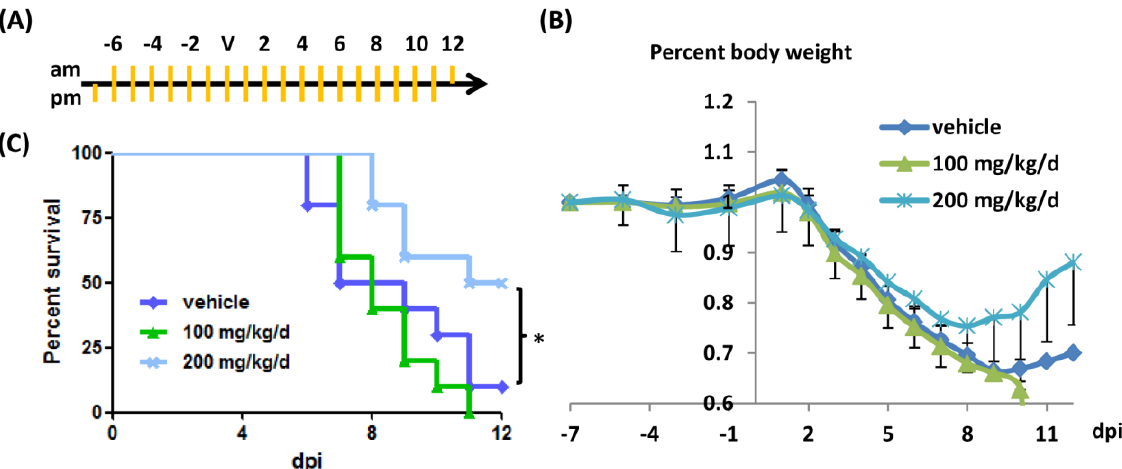
Figure 5. Efficacy of EAex on mouse models. EAex or Tamiflu were prepared in 5% DMSO, and mice were administered with 100 µL of solution twice a day by per os (daily uptake was as indicated). ( a ) indication of administration (orange lines) and virus challenge (V); ( b ) average body weight percent (normalized with D-7 body weight); ( c ) Survival rate comparison of DMSO and EAex (100 mg/kg/d or 200